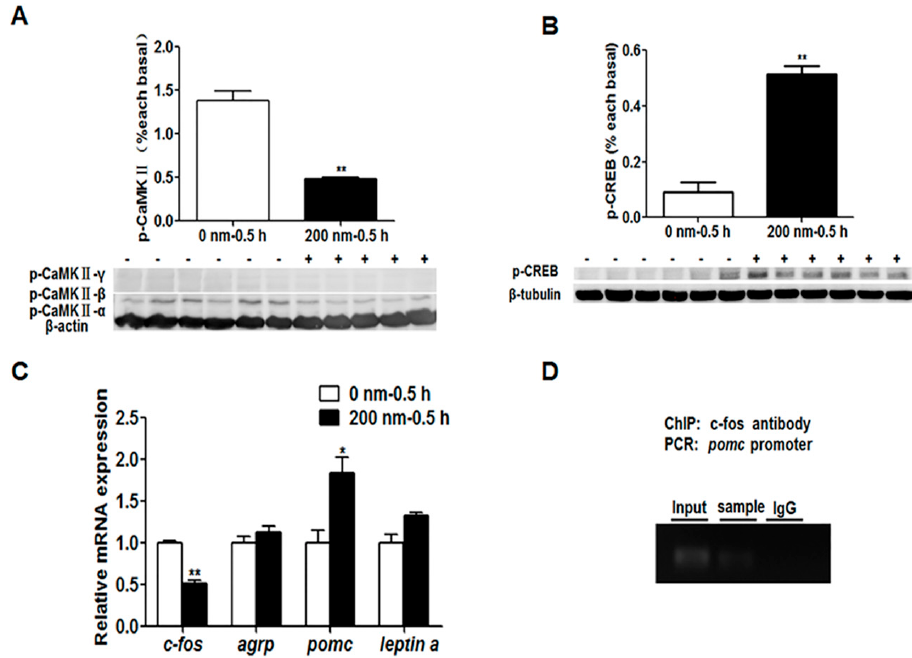
Figure 14. The p-CaMKII ( A ) and p-CREB levels ( B ), and learning and appetite control-relative genes expression ( C ) in mandarin fish brain cells with the treatment of inhibitor KN-62 (200 nm, 0.5 h). Chromatin immunoprecipitation (ChIP) assays with anti-c-fos antibody or control mouse IgG ( D ) for the determination of c-Fos binding sites in the pomc promter in the brain tissue of KM mice (Kunming mice). Data are represented as mean ± S.E.M. ( n = 6). A value followed by * differs significantly from all other values not followed by the same superscript at the same time point based on a one-way analysis of variance (ANOVA) followed by the post hoc test ( * p < 0.05, ** p < 0.01).